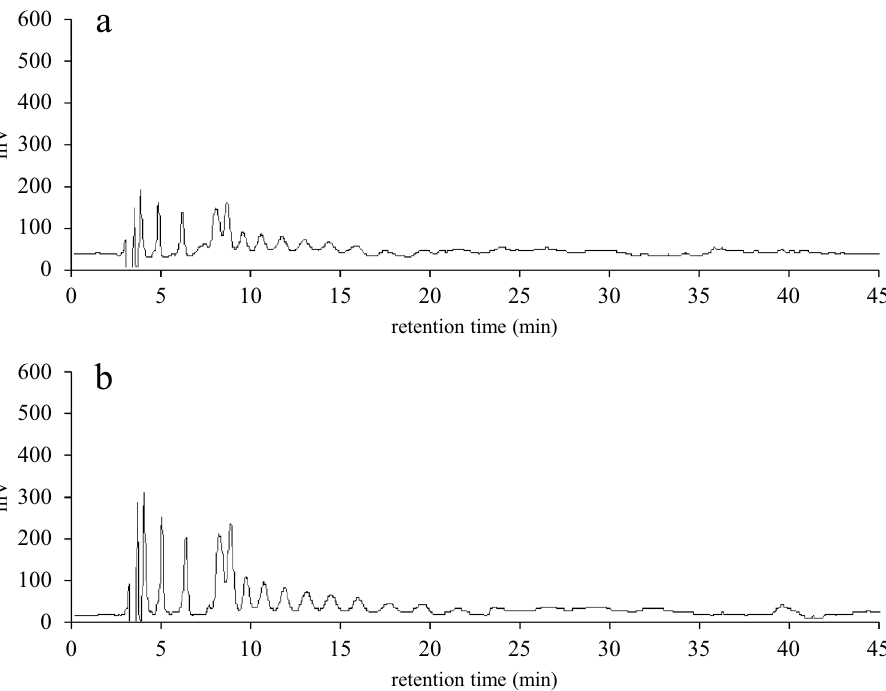
Figure 6. Comparison of intracellular inulin of UT02 (Ldb1381-1386 introduced 168 strain) and UT05 (Ldb1381-1386 introduced 168 strain with sacC deletion) cells. The cell lysates were prepared as described in Fig. 4, and intracellular inulin polymers were analyzed by HPLC. Inulin elution patterns after 2 h -incubation of UT02 ( a ) and UT05 ( b ) are